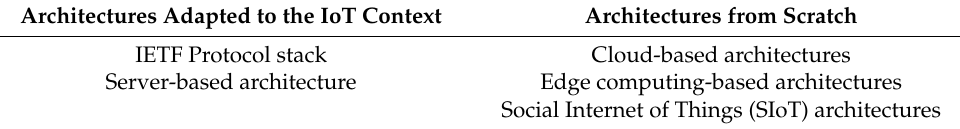
Table 3. Example of IoT